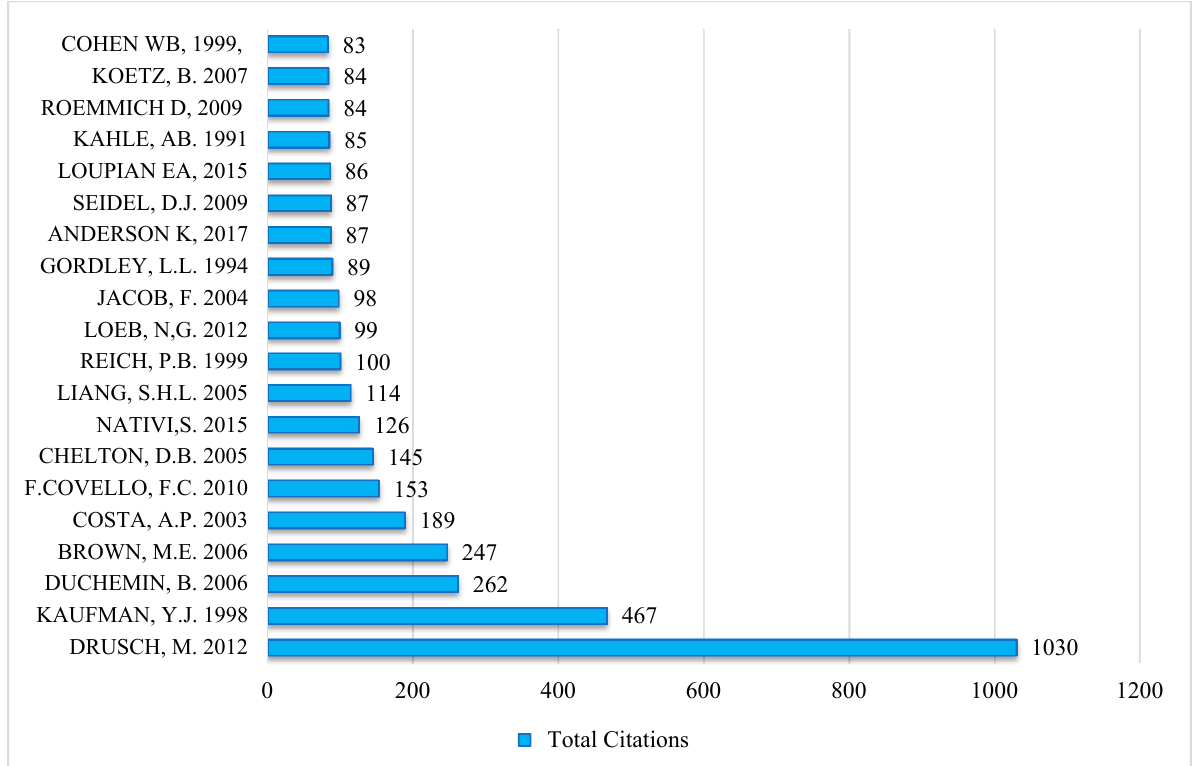
Figure 5. Top 20 global citations of authors on EOS and PM from 1979–2019.